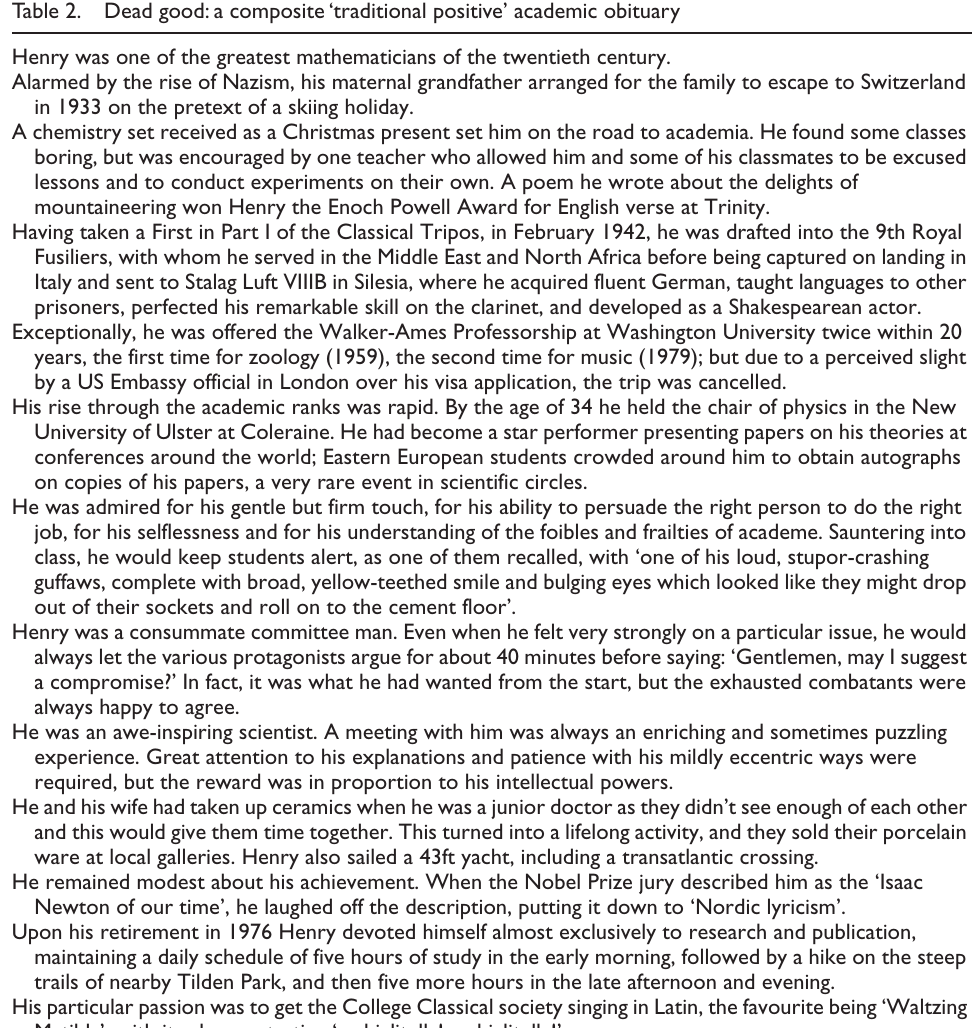
Table 2. Dead good: a composite ‘traditional positive’ academic obituary Henry was one of the greatest mathematicians of the twentieth century. Alarmed by the rise of Nazism, his maternal grandfather arranged for the family to escape to Switzerland in 1933 on the pretext of a skiing holiday. A chemistry set received as a Christmas present set him on the road to academia. He found some classes boring, but was encouraged by one teacher who allowed him and some of his classmates to be excused lessons and to conduct experiments on their own. A poem he wrote about the delights of mountaineering won Henry the Enoch Powell Award for English verse at Trinity. Having taken a First in Part I of the Classical Tripos, in February 1942, he was drafted into the 9th Royal Fusiliers, with whom he served in the Middle East and North Africa before being captured on landing in Italy and sent to Stalag Luft VIIIB in Silesia, where he acquired fluent German, taught languages to other prisoners, perfected his remarkable skill on the clarinet, and developed as a Shakespearean actor. Exceptionally, he was offered the Walker-Ames Professorship at Washington University twice within 20 years, the first time for zoology (1959), the second time for music (1979); but due to a perceived slight by a US Embassy official in London over his visa application, the trip was cancelled. His rise through the academic ranks was rapid. By the age of 34 he held the chair of physics in the New University of Ulster at Coleraine. He had become a star performer presenting papers on his theories at conferences around the world; Eastern European students crowded around him to obtain autographs on copies of his papers, a very rare event in scientific circles. He was admired for his gentle but firm touch, for his ability to persuade the right person to do the right job, for his selflessness and for his understanding of the foibles and frailties of academe. Sauntering into class, he would keep students alert, as one of them recalled, with ‘one of his loud, stupor-crashing guffaws, complete with broad, yellow-teethed smile and bulging eyes which looked like they might drop out of their sockets and roll on to the cement floor’. Henry was a consummate committee man. Even when he felt very strongly on a particular issue, he